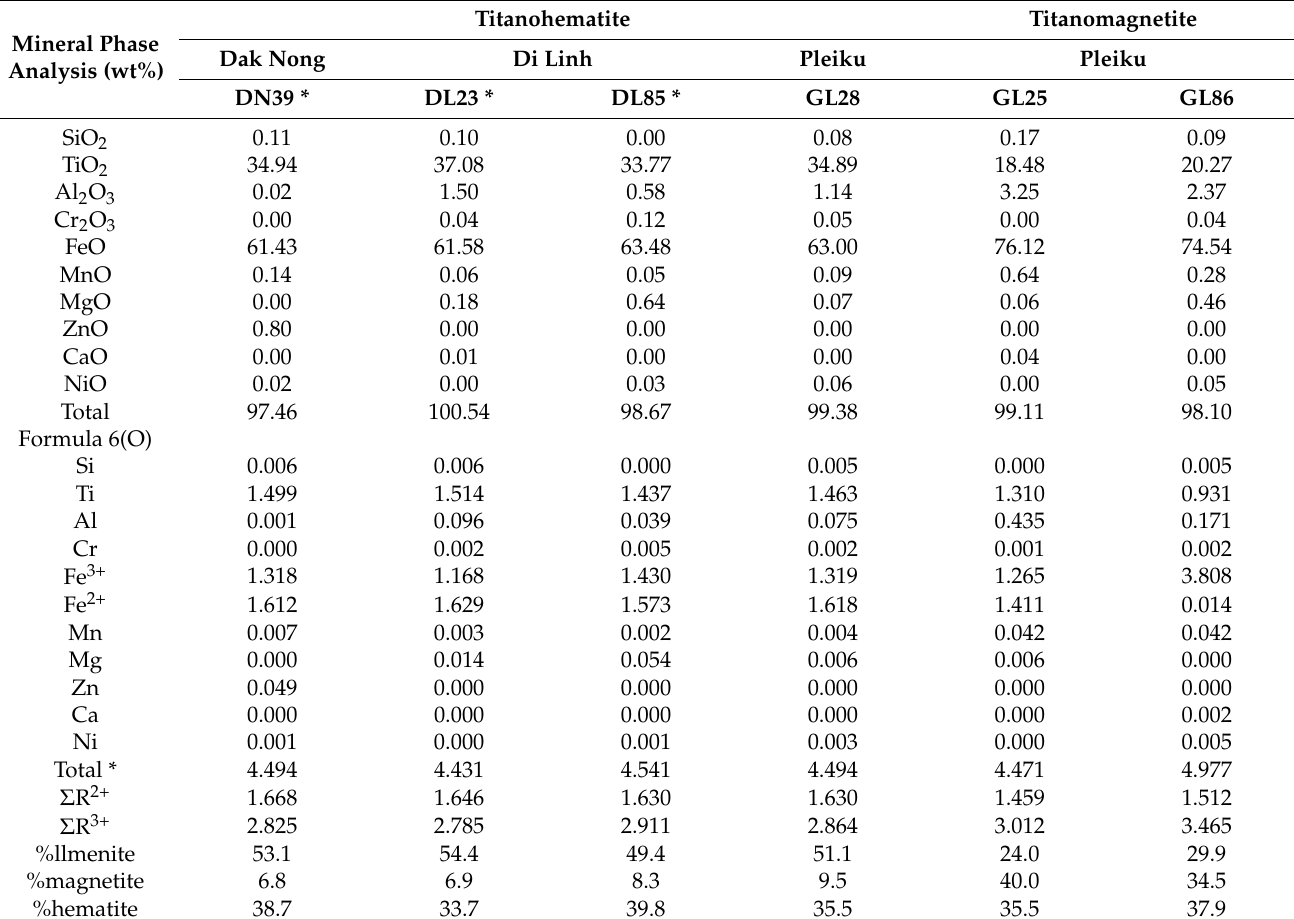
Table 3. Representative EPMA analyses of ilmenite inclusions in sapphire from Southern